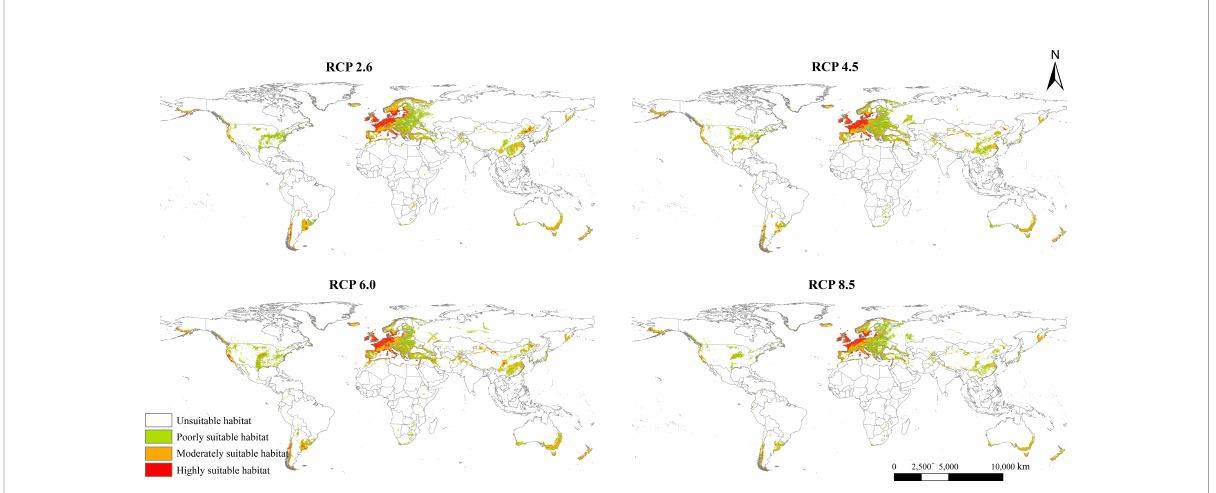
FIGURE 4 Potential global geographical distribution of Lolium temulentum under four climate scenarios in the 2050s, namely RCP 2.6, RCP 4.5, RCP 6.0, and RCP